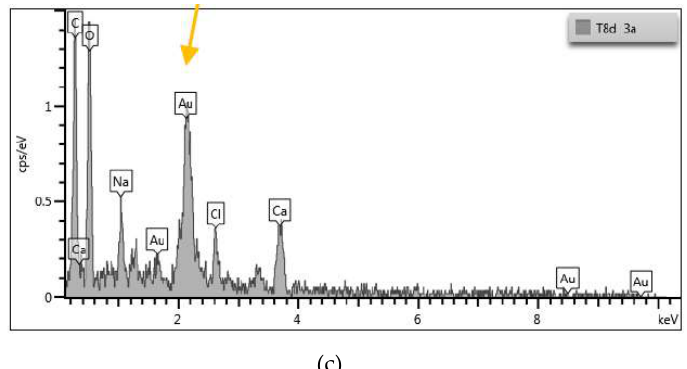
Figure 3 . SEM micrographs of L. sphaericus CBAM5 cells ( a ) inside the alginate sphere seen with retro-dispersed electrons. ( b ) Close-up of image (a) seen with retro-dispersed electrons. ( c ) EDS analysis of image (b) showing the presence of Au in the matrix.